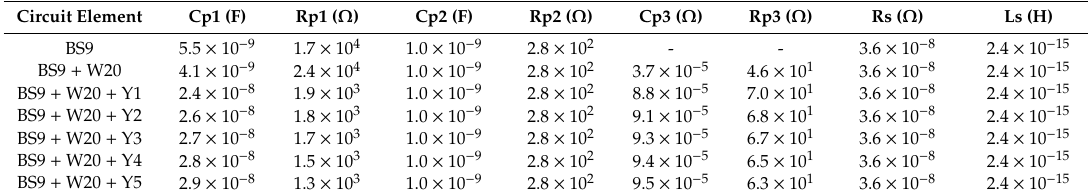
Table A12. Modeled impedance parameters Cp1, Rp1, Cp2, Rp2, Cp3, Rp3, Rs, and Ls of biochip BS9, with DI water and S.